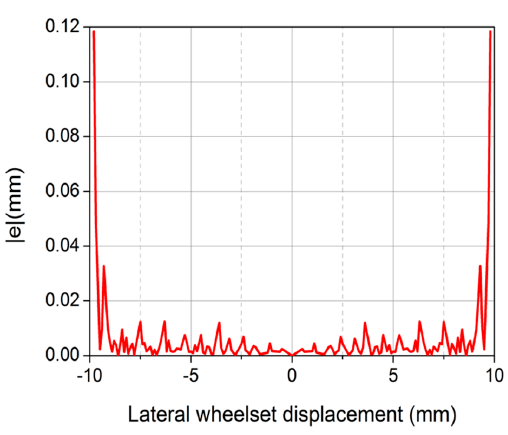
Figure 16. Absolute value of the error e in rolling radii difference distribution.